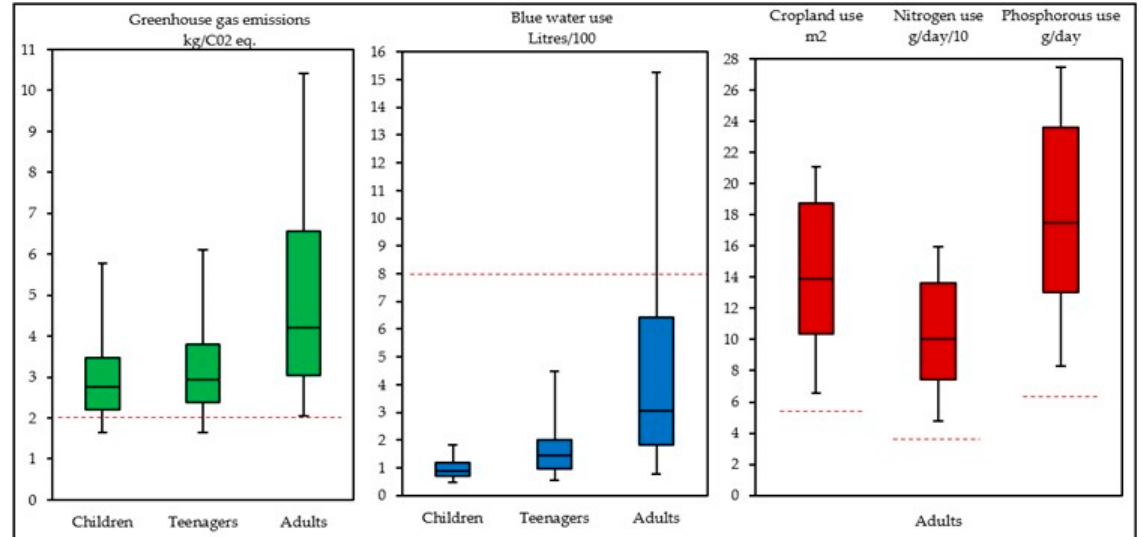
Figure 1. Environmental impact of diets reported in the Irish FCDB in relation to planetary boundaries (per capita). Cropland use is shown in m 2 ; Nitrogen use in g/day/10; Phosphorous use is shown in g/day. Red dashed lines indicate planetary boundaries, calculated as food related limits divided by the global population [31]. Includes diets reported for children ( n = 2375); teenagers ( n = 798); and adults ( n = 4575). Planetary boundaries as red broken lines as 1.87 kgCO 2 eq GHGe, 786 L blue water use, 5.01 m 2 cropland use, 27.4 g N nitrogen use and 6.35 g P phosphorus use [32] per capita per day.